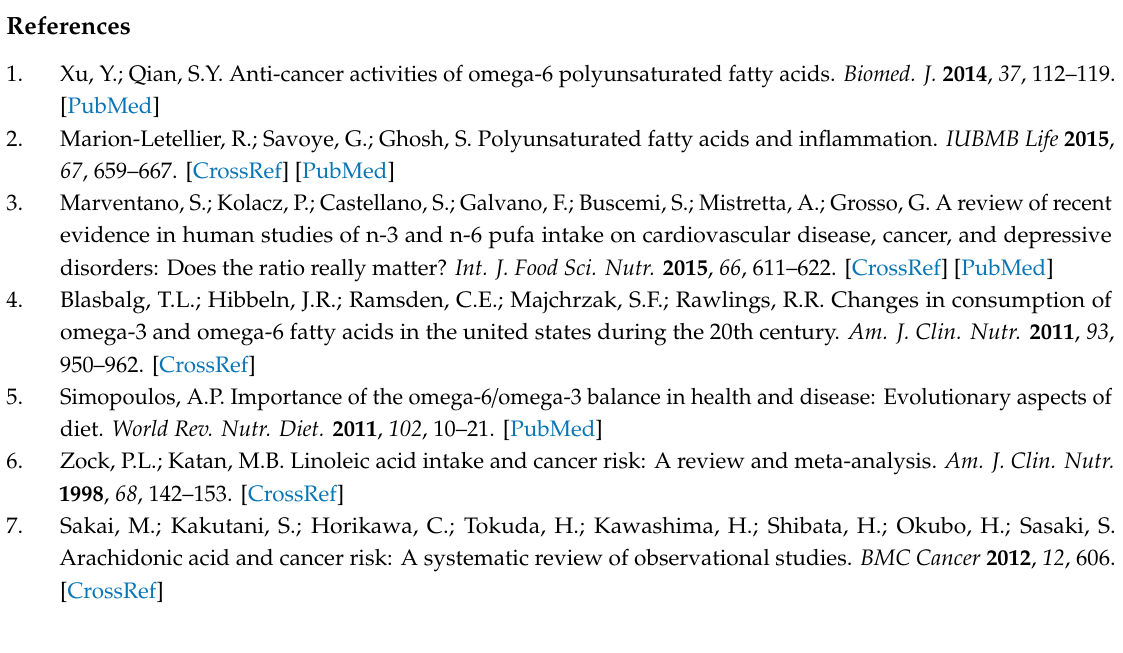
Table S1: Characteristics of Prospective Studies Included in the Meta-Analysis of n-6 polyunsaturated fatty acid (PUFA) intake and colorectal cancer, Table S2: Characteristics of Prospective Studies Included in the Meta-Analysis of blood levels of n-6 polyunsaturated fatty acids (PUFAs) and colorectal cancer Figure S1: Flow chart of study